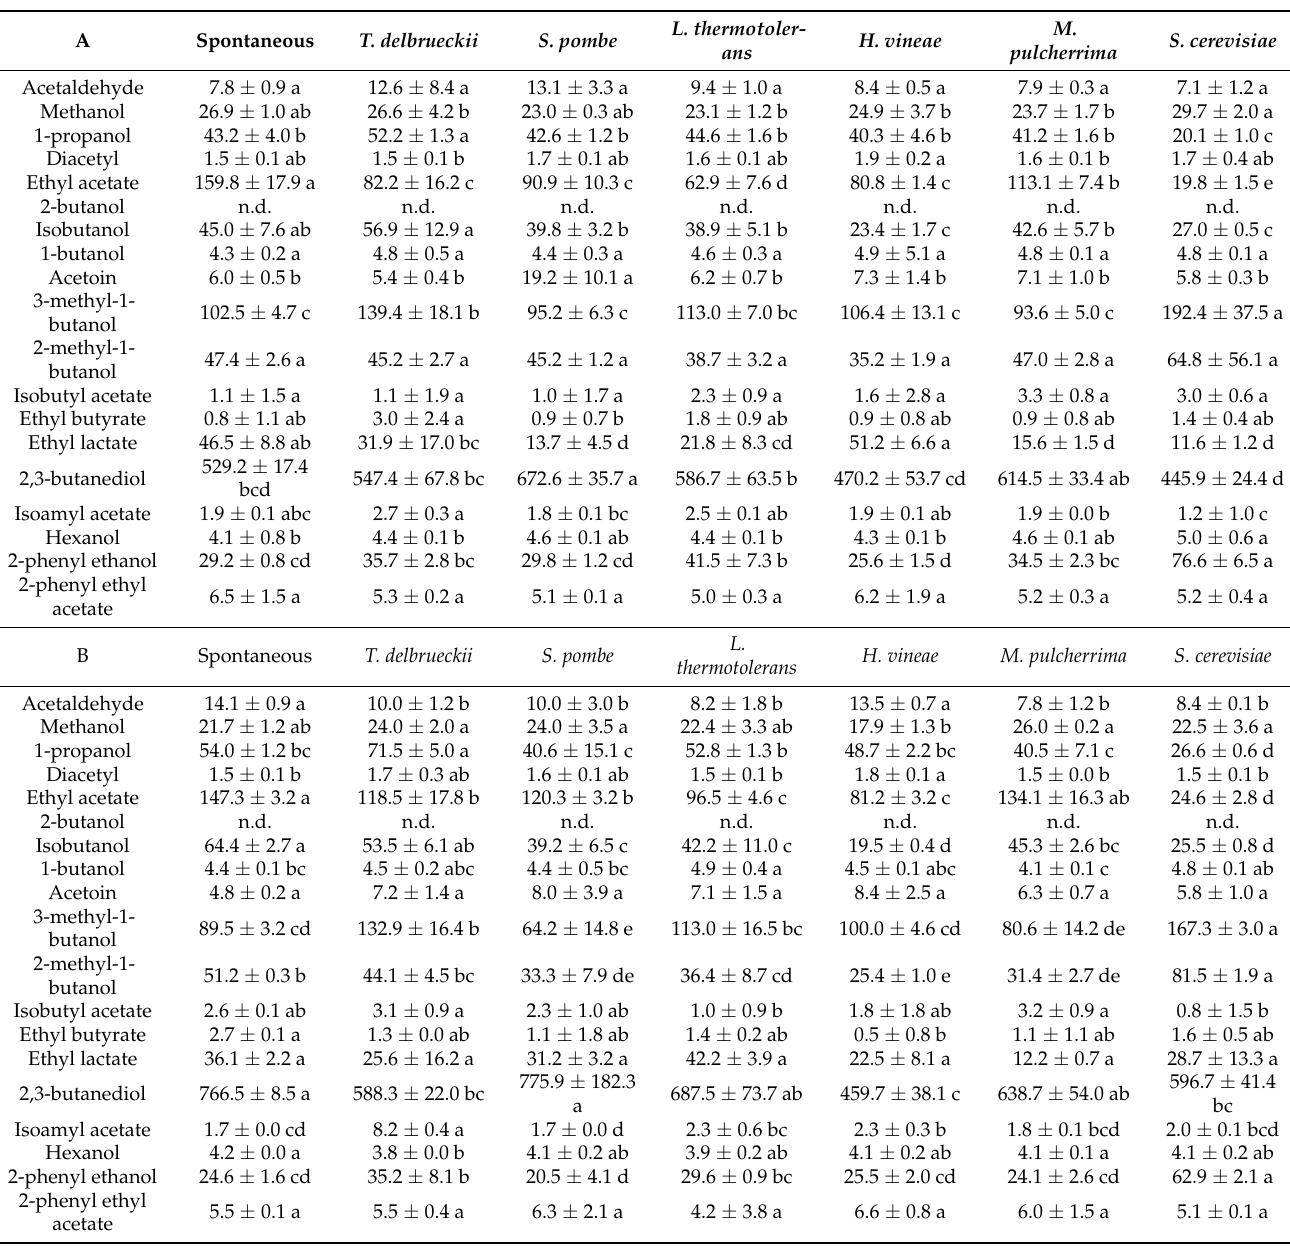
Table 3. Volatile fraction, in mg/L, determined with flame ionization detector (GC-FID). The results correspond to (A) control fermentations and (B) PL treatment. Average and STD for n = 3. Different letters indicate a significant difference within the same treatment for each